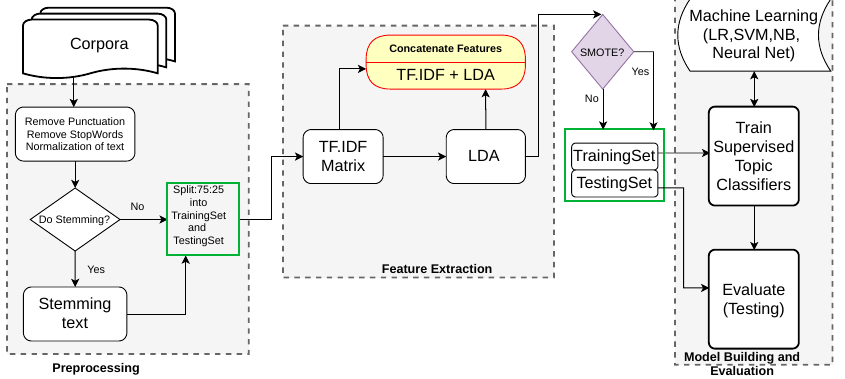
Figure 1. Workflow of the Topic Detection with Supervised Approach.